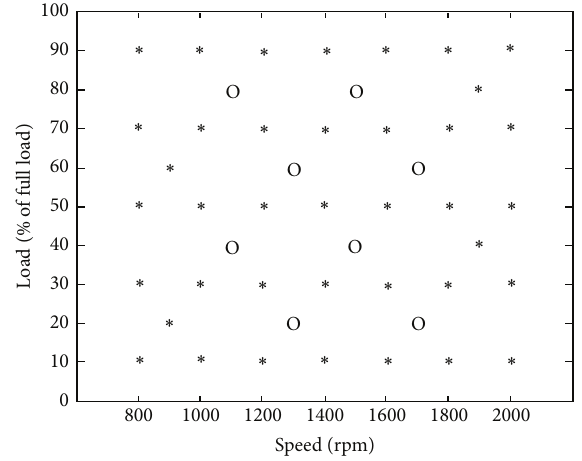
Figure 2: Engine operating conditions (o: validation data; ∗ : training data)